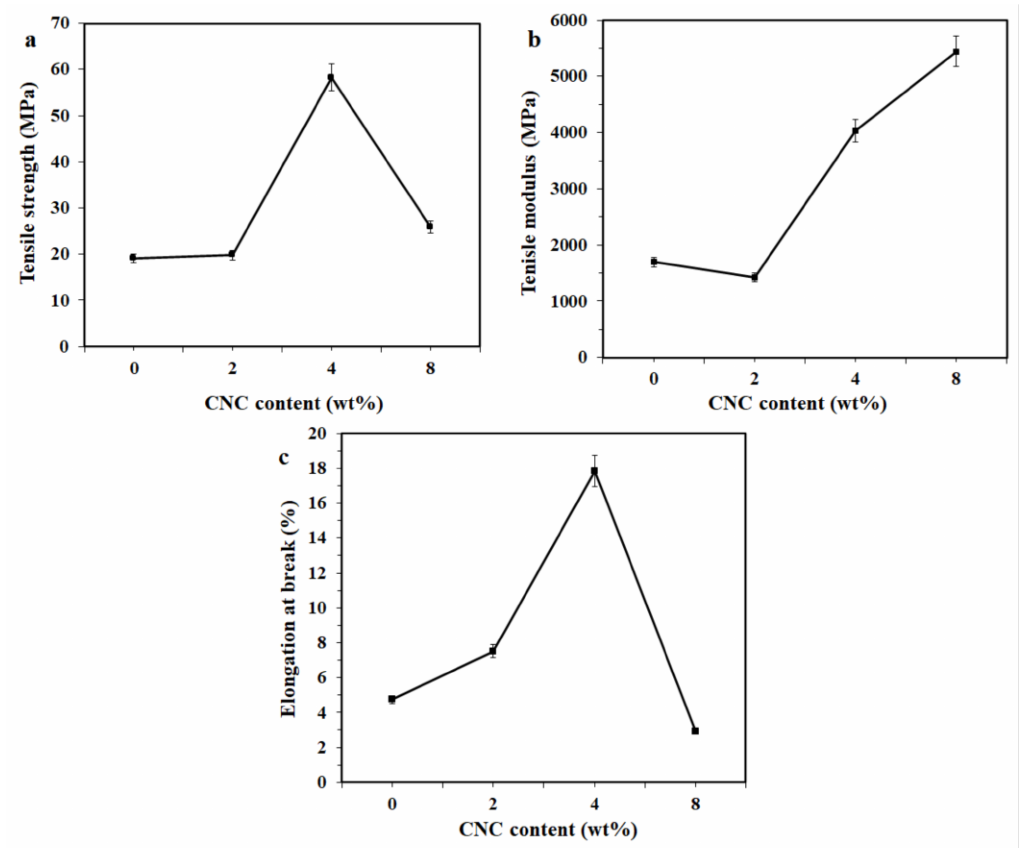
Figure 4. ( a ) Tensile strength of the chitosan/cellulose nanocrystal (CNC) bio-composite films with varying CNC contents, ( b ) tensile modulus, and ( c ) elongation at